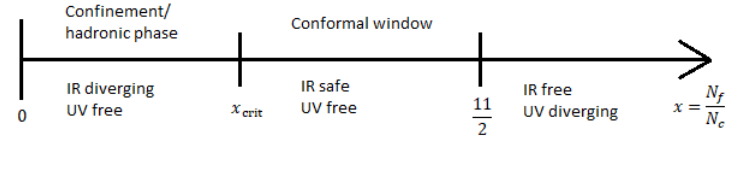
Figure 1. Phase diagram of QCD as a function of x = N chemical